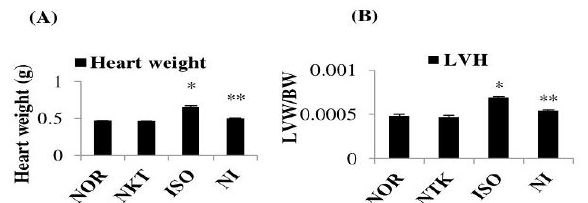
Figure 4. E ff ect of NKT on heart weight and left-ventricular hypertrophy (LVH): ( A ) heart weight and ( B ) LVH in the myocardium. Each column is the mean ± SEM for eight rats in each group; * p < 0.05 as compared to the normal control (Group-I), ** p < 0.05 as compared to the ISO control (Group-III) (DMRT).